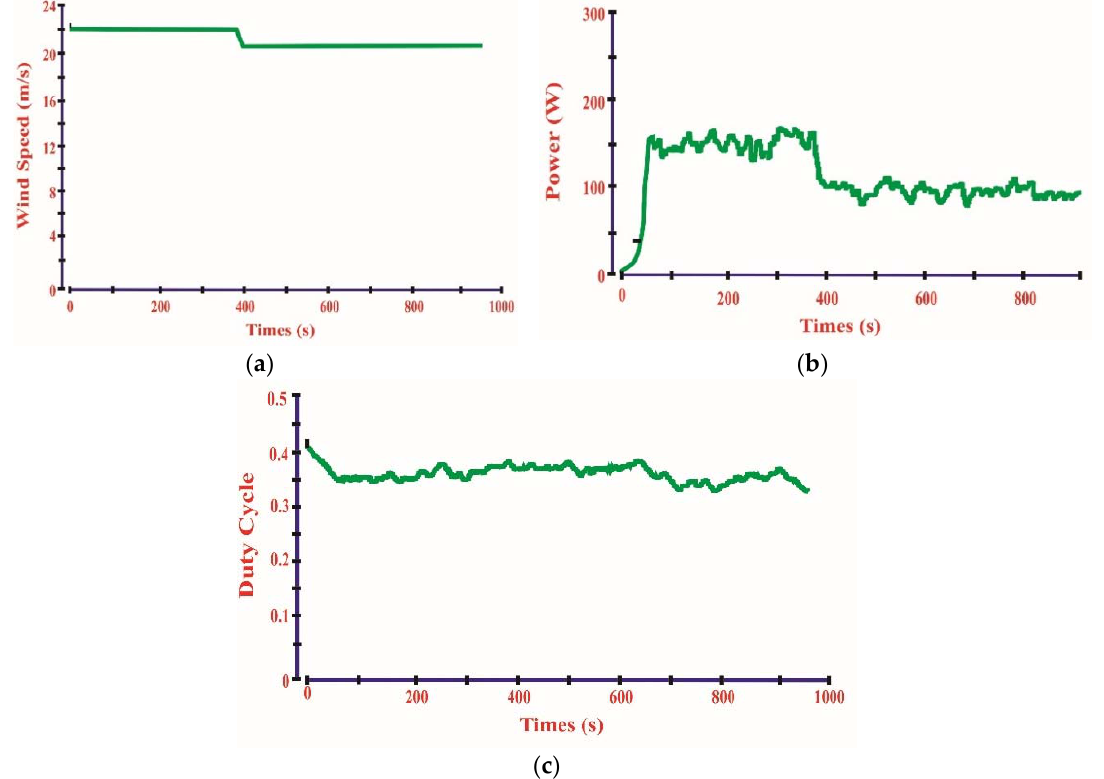
Figure 11. Experimental results ( a ) during a step-changed in wind speed; ( b ) wind power; and ( c ) Duty cycle of Cuk converter.